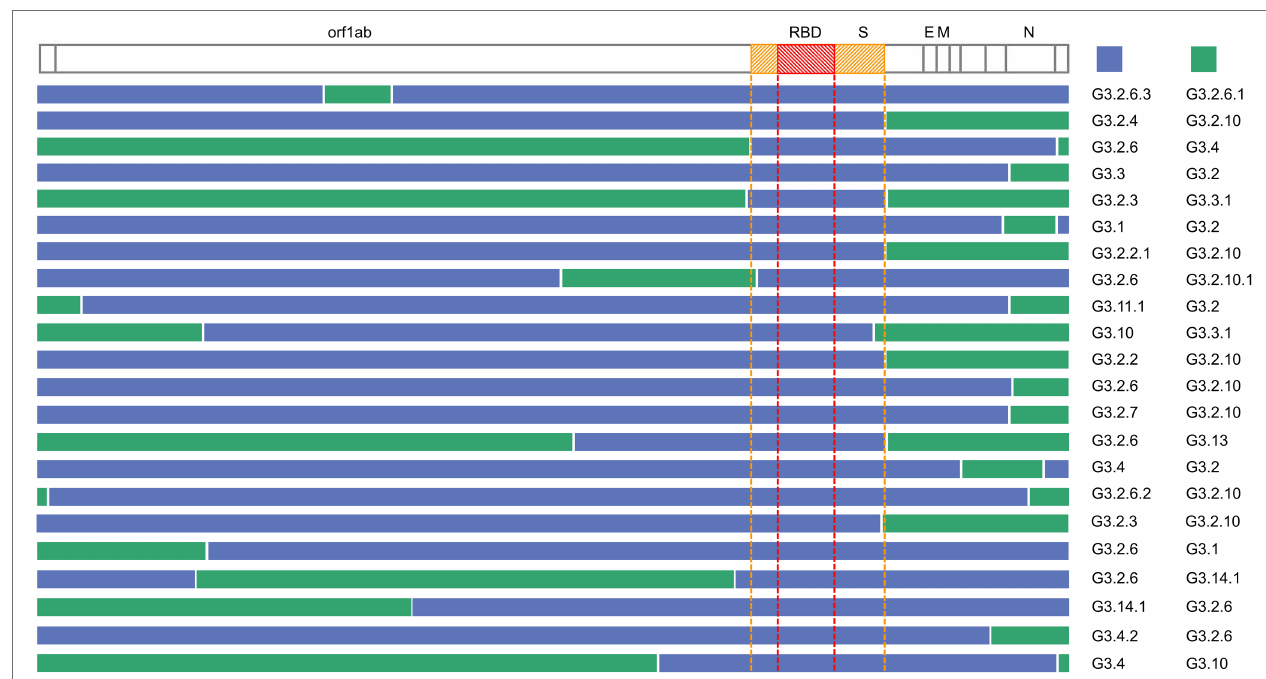
FIGURE 5 | Summary of the recombination sites in the detected recombination types. Blocks matching the parental group contributing the S gene are shown in blue, while blocks matching other groups are colored in green. The region between the yellow dotted lines is the S gene, and the region between the red dotted lines is